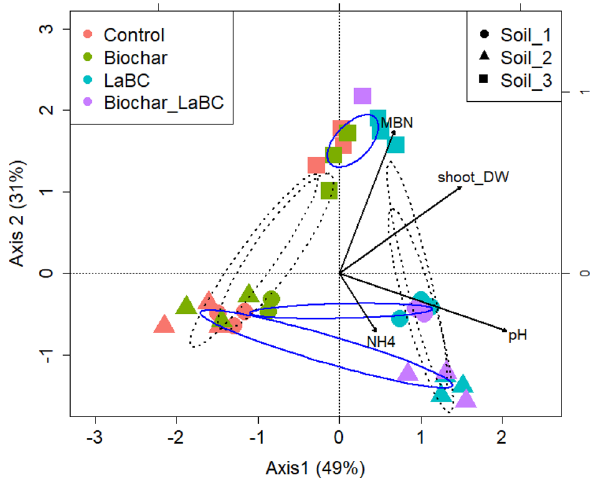
Figure 3. Canonical correspondence analysis (CCA) biplot showing the relationship between soil type, soil amendments and measured soil variables for three soils of contrasting textures (Soils 1, 2 and 3; sand, sandy loam and clay respectively) amended with LaBC, Biochar and Biochar + LaBC after 8 weeks with subterranean clover. Arrows represent the measured variables (pH, NH 4 + , MBN). Blue ellipses separate the samples by soil types whilst black dash line ellipses separate the samples by